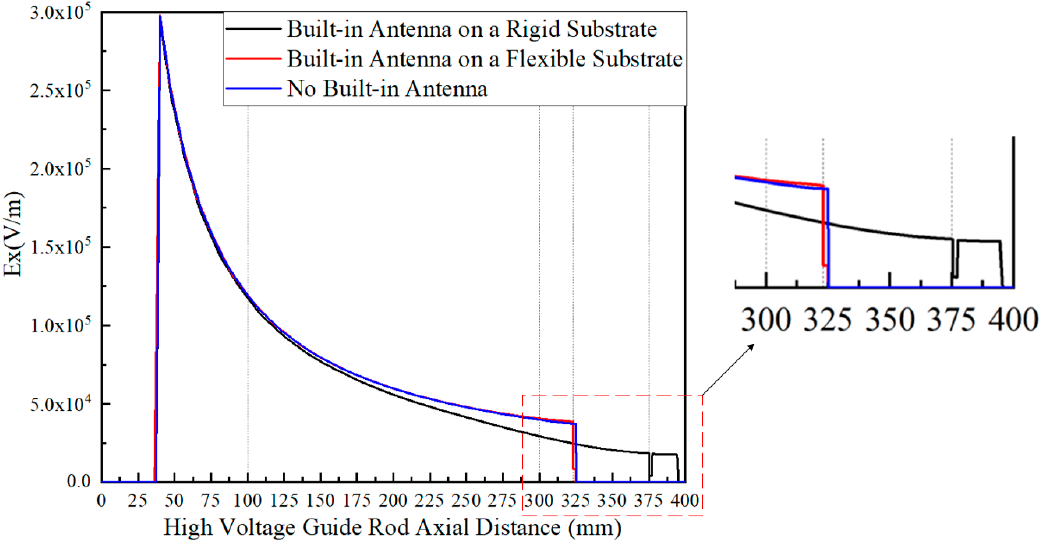
Figure 13. Simulation of the electric field distribution inside the GIS.